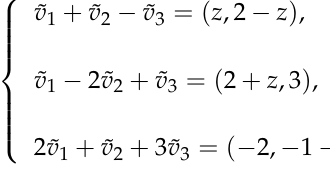
Figure 3. The solutions of example